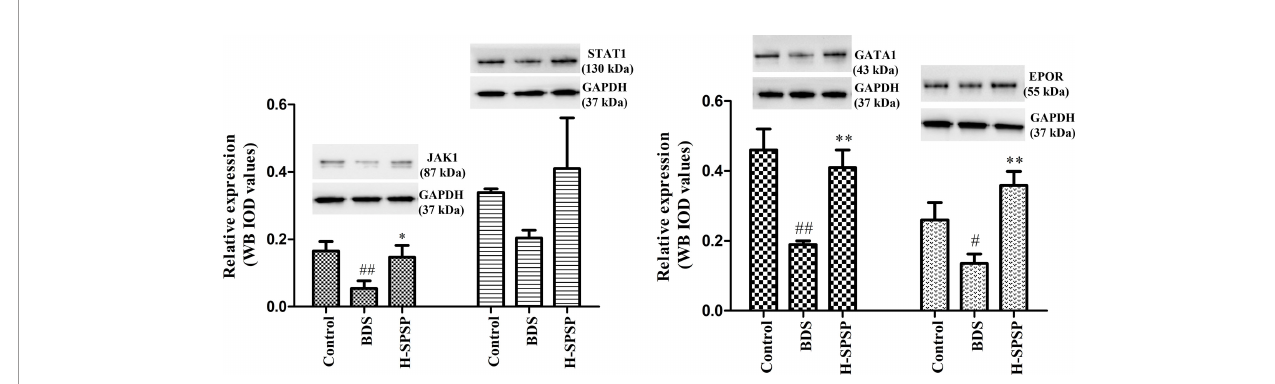
FIGURE 9 | The effects of H-SPSP on protein expression levels of Jak1, Stat1, EPOR and GATA1 in BDS mice. The protein expression levels were normalized to GAPDH and expressed in terms of the fold change relative to the levels in the control group. Each value represents the mean ± SD (n = 3); # p < 0.05, ## p < 0.01 versus Control group. * p < 0.05, ** p < 0.01 versus BDS.